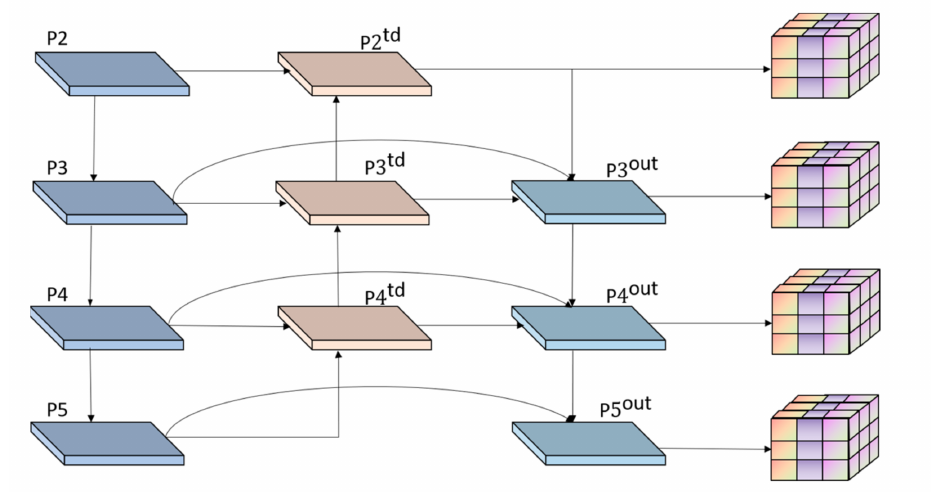
Figure 8. Improved feature fusion network.